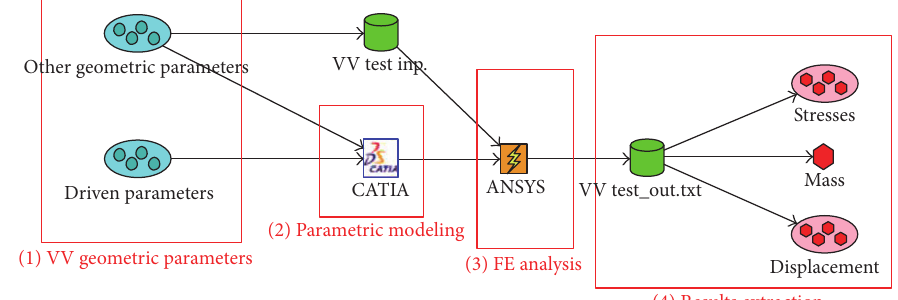
Figure 3: VV workflow in OPTIMUS.